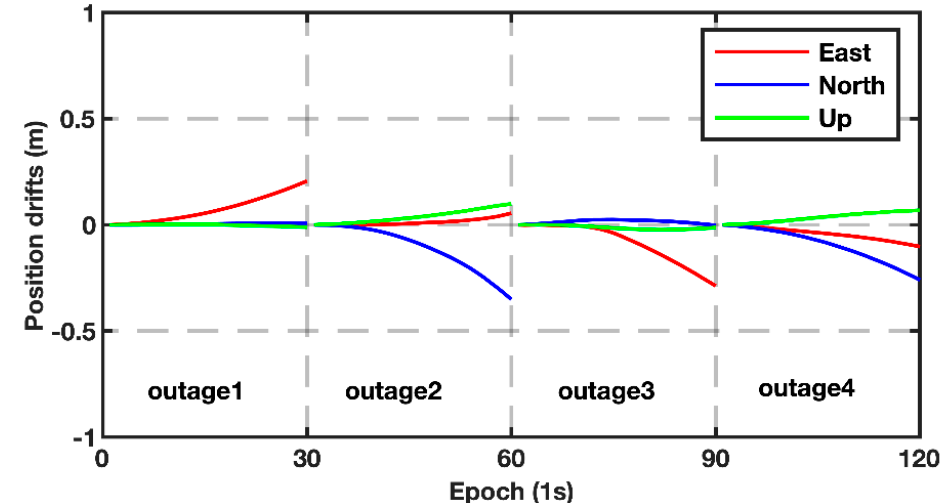
Figure 6. Positioning errors of the PPP-B2b/tactical − IMU loosely coupled integration during the simulated GNSS signal outages. Table 4. Statistics of positioning errors for PPP-B2b/INS loosely coupled integration during GNSS outages (unit: cm).